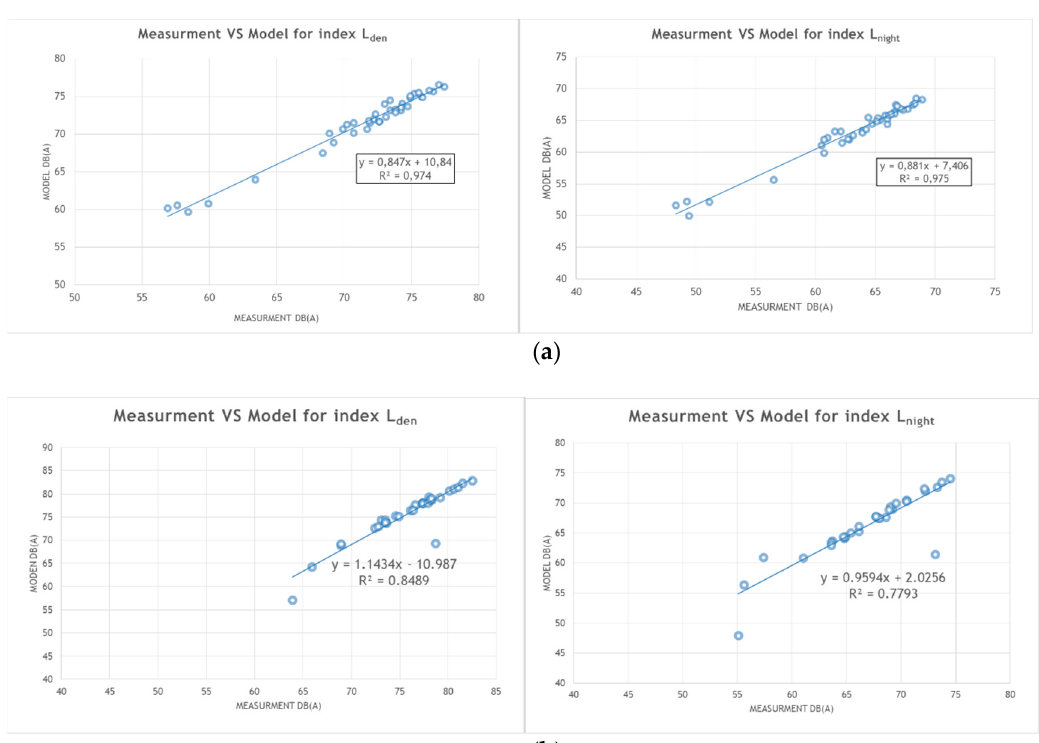
Figure 4. Comparison between the theoretical results from the CadnaA and the measurement results in the city of Heraklion ( a ) and in the city of Corfu ( b